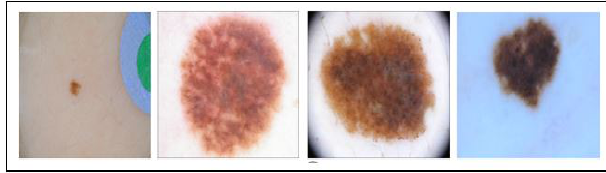
Figure 11. Images from ISIC Melanoma Dataset Table 2. Comparison results of